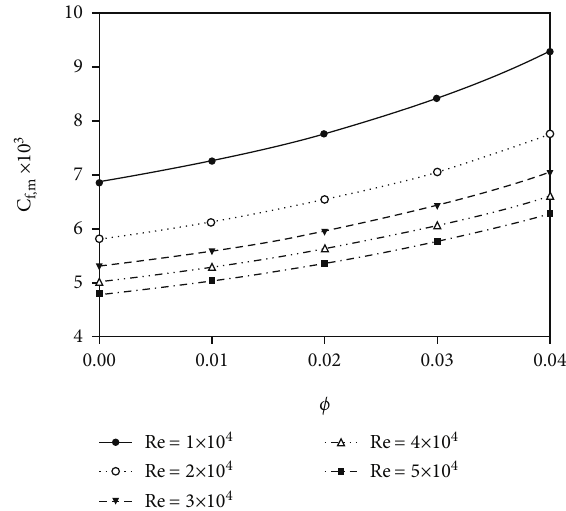
Figure 8: Changes in skin friction based on volume fraction of nanoparticles for di ff erent Reynolds ’